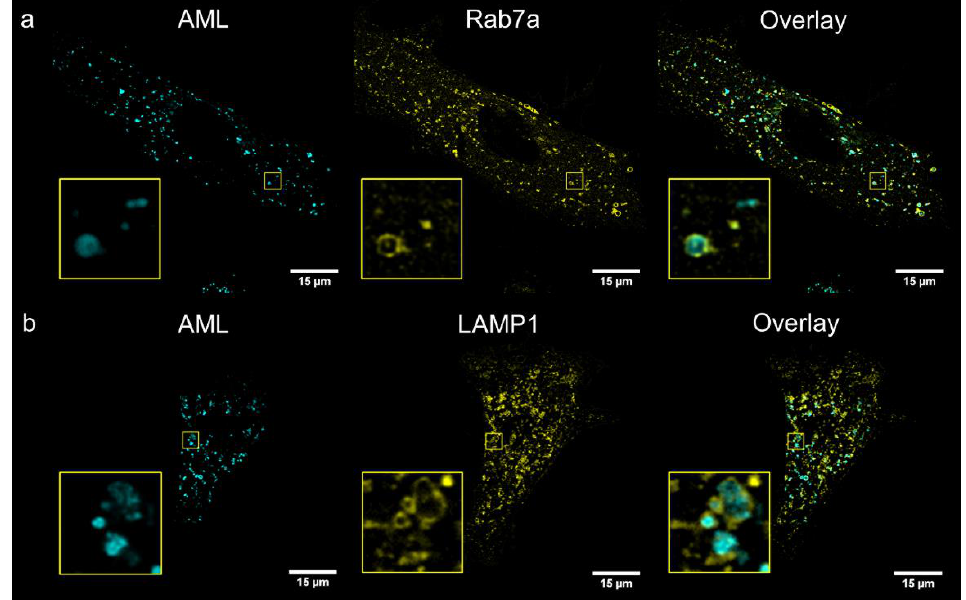
Figure 4. Confocal images of living A7r5 cells after 1 h incubation with 300 nM AML (cyan) and co-stained with CellLight ® emGFP trackers (yellow) ( a ) late endosomes marker Rab7a, ( b ) lysosomes marker LAMP1. Whole cells and selected ROIs 5 × 5 µm are shown. The cells were incubated in HBSS supplemented with 20 mM HEPES (pH 7.4), then washed twice and imaged on confocal Leica SP8 microscope as described in the Materials and Methods section.